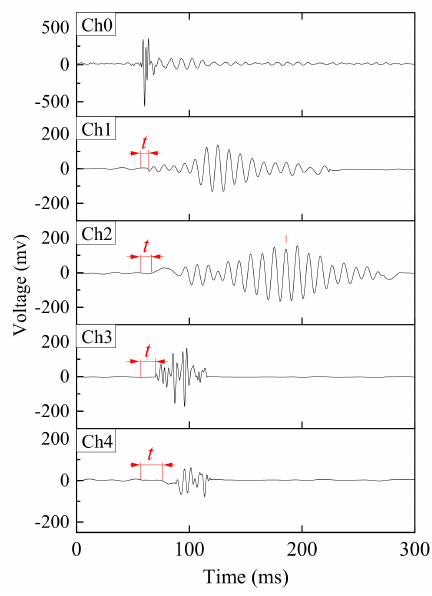
Figure 8. Example of transmitted and received signals obtained from large-scale model